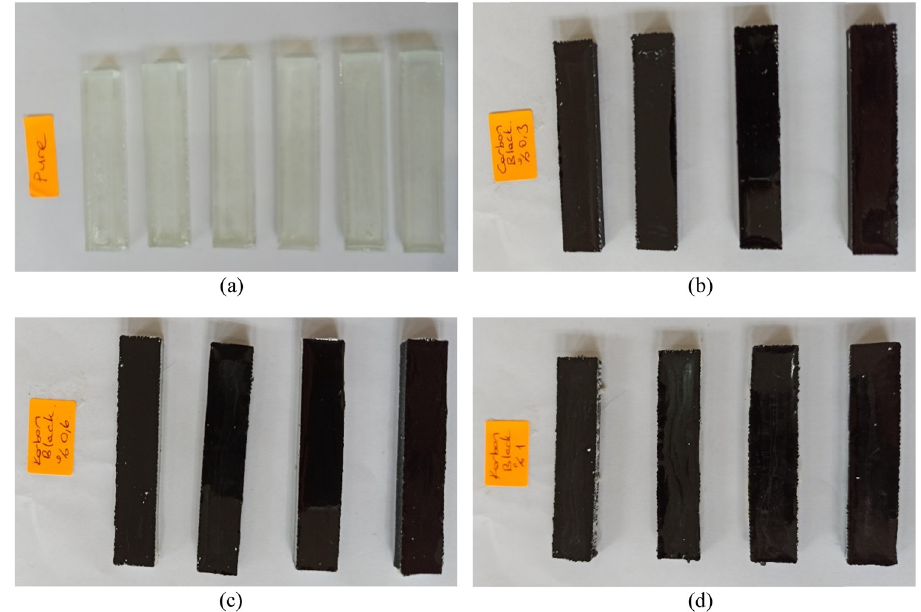
Figure 3: Di ff erent proportions of carbon black added samples and neat samples: ( a ) neat samples, ( b ) 0.3% carbon black added samples, ( c ) 0.6% carbon black added samples, and ( d ) 1% carbon black added samples.